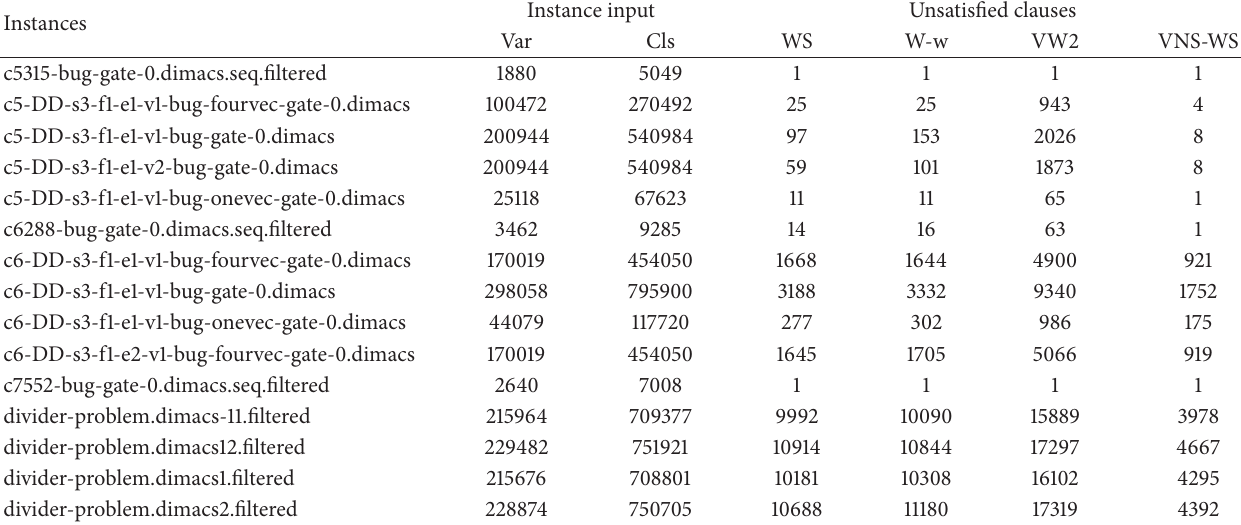
Table 2: SAT2013 industrial benchmarks: comparison among VNS-WS, WS, W-w, and